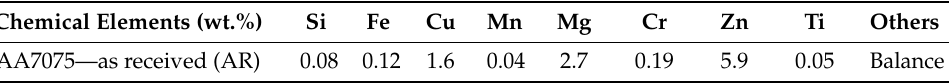
Table 1. Chemical composition of